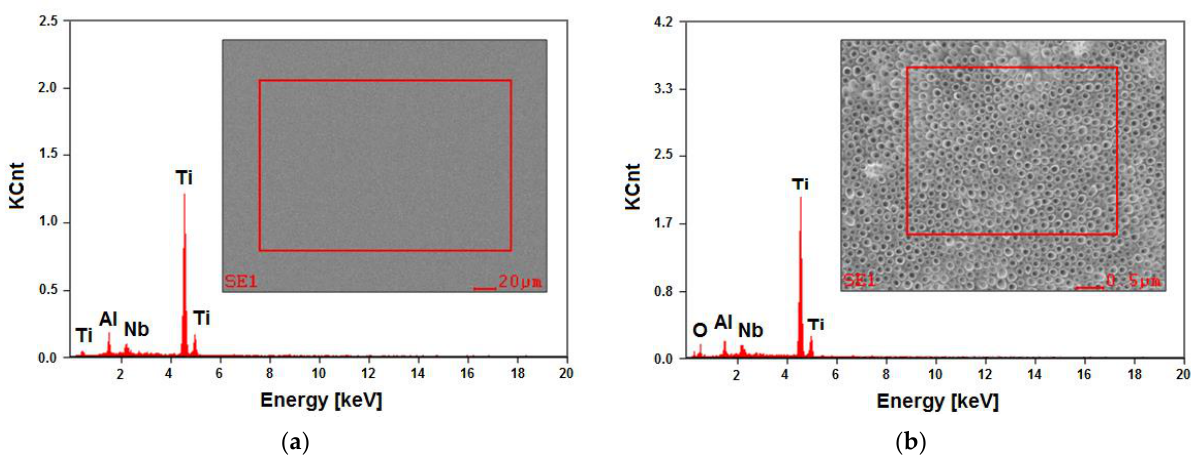
Figure 4. EDAX spectrum with a selected micro-area for analysis from the Ti – 6Al – 7Nb alloy surface: ( a ) before anodizing; ( b ) after anodizing at 15 V for 60 min.